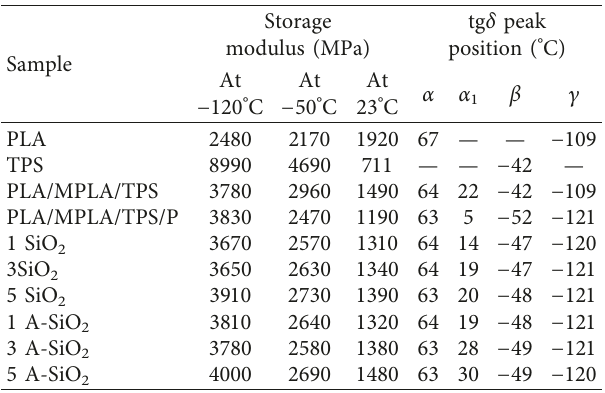
Table 6: DMTA results of PLA, TPS, and various PLA/MPLA/TPS blends and